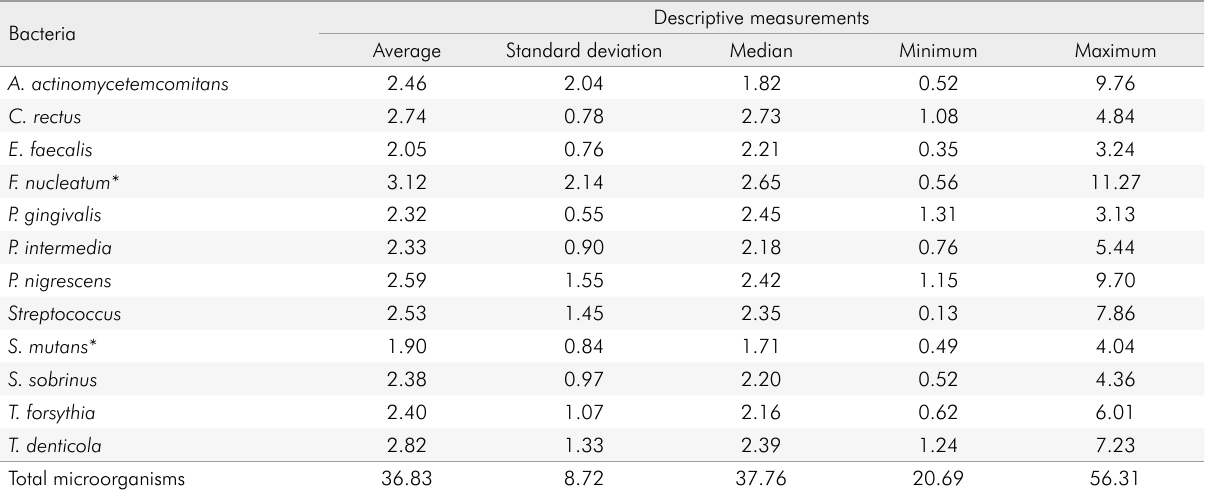
Table 2. Descriptive measurements (average, standard deviation, median and maximum and minimum numbers) for density of bacteria (cell/mL x 10 8 ) in primary teeth with pulp canal and chamber necrosis.